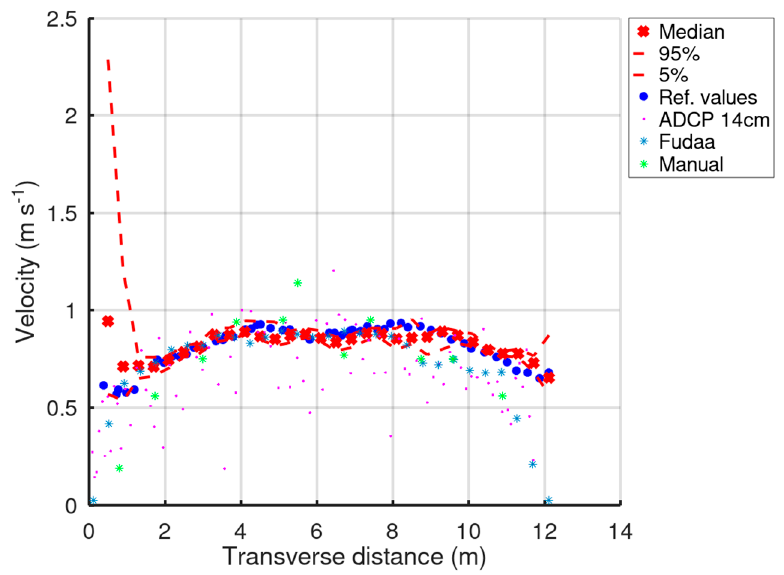
Figure 9. Murg River. The Free-LSPIV 90% confidence interval and median values, the reference values, the surface velocities obtained with Fudaa-LSPIV, and the surface velocities estimated manually. The observations obtained with ADCP at 14 cm are also displayed with magenta dots.